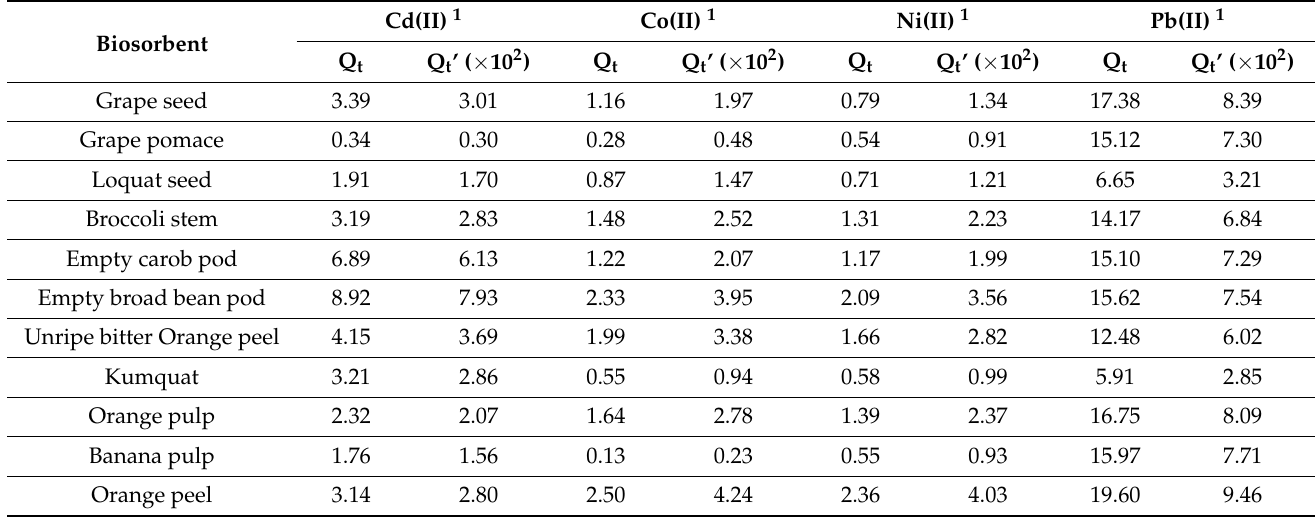
Table 4. Biosorption capacity Q t (mg g − 1 ) and normalized biosorption capacity Q t ’ (mmol g − 1 ) for